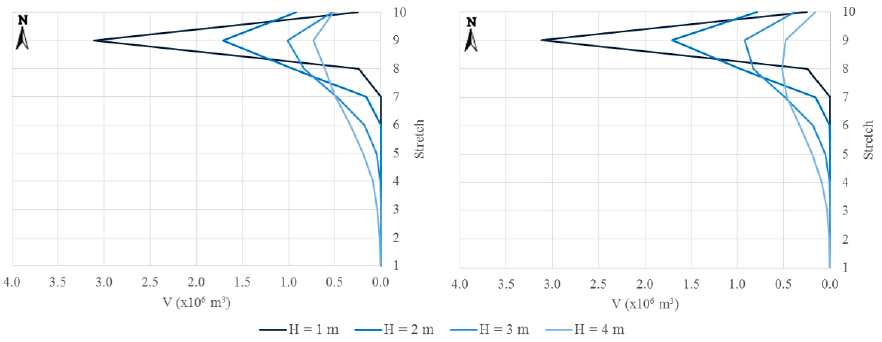
Figure 9. Sediment volumes due to artificial nourishment after the fifth year of simulation ( θ = 85 ◦ ): Clo/Clo ( left ); Ext/Ext ( right ) (based on [41,42]).